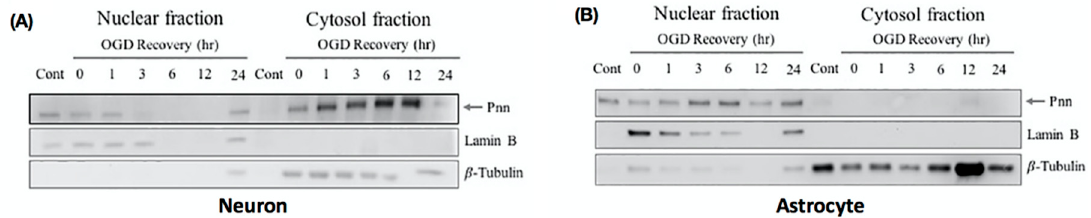
Figure 3. Oxygen-glucose deprivation and reoxygenation induces cytoplasmic translocation of Pnn in neurons. To examine the subcellular localization of Pnn during reoxygenation, cellular fractionation was applied to separate nuclear and cytoplasmic proteins of neurons ( A ) and astrocytes ( B ) at different time points during reoxygenation. Western blotting was performed to examine protein expression levels of Pnn, lamin B (a nuclear envelop protein, nuclear fraction maker), and β -tubulin (a cytoskeleton protein, cytoplasmic fraction marker).